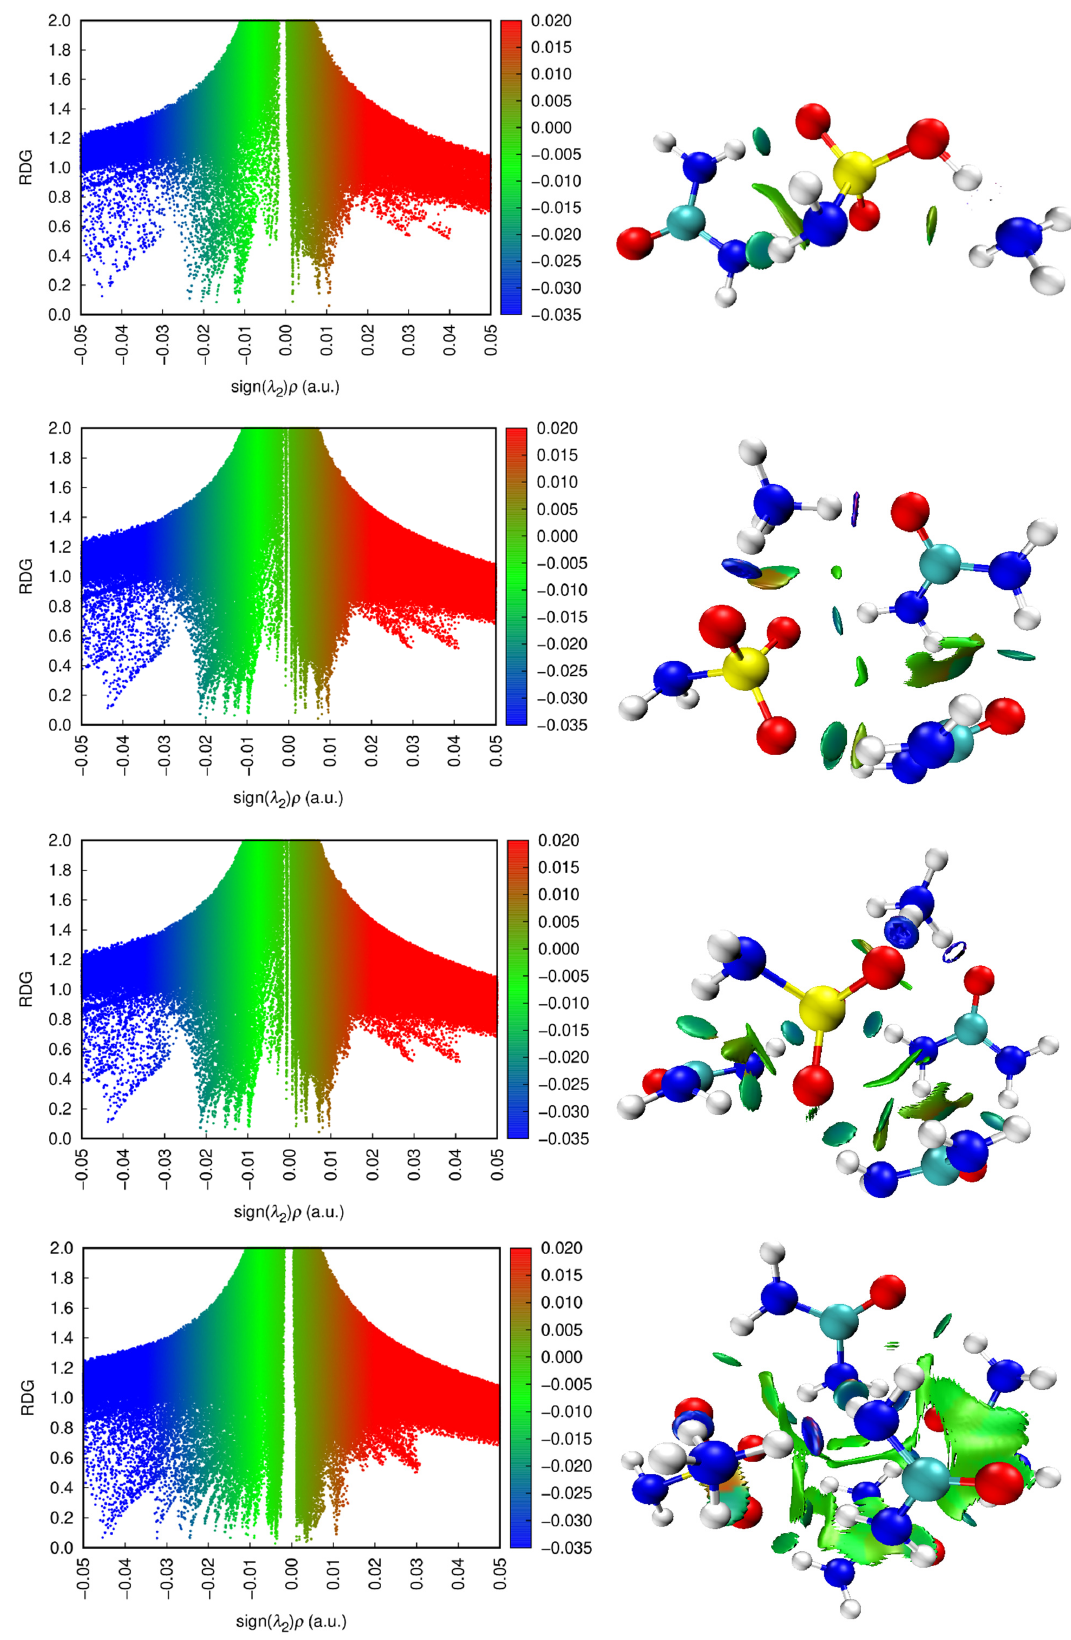
Figure 10. RDG scatter ( left ) and NCI ( right ) plots for the investigated system. The ELF maps highlight zones of molecular space; the maps of their color shades are shown in Figure 11. This topological surface analysis is based on covalent bonds, in which the electron pair detection is high. The ELF calculation takes into account the ki- netic energy density [63,64]. The ELF value τ (r) ranges from 0.0 to 1.0; relatively full values of 0.5 and 1.0 corre- spond to the contours containing localized bonding and nonbonding electrons [62]. The low (< 0.5) values correspond to the contours in which electrons should be delocalized [65]. Figure 11 shows the high ELF regions around hydrogen atoms, which are indicative of the presence of highly localized bonding and nonbonding electrons, and the blue re- gions around several oxygen and nitrogen atoms show a delocalized electron cloud around them.